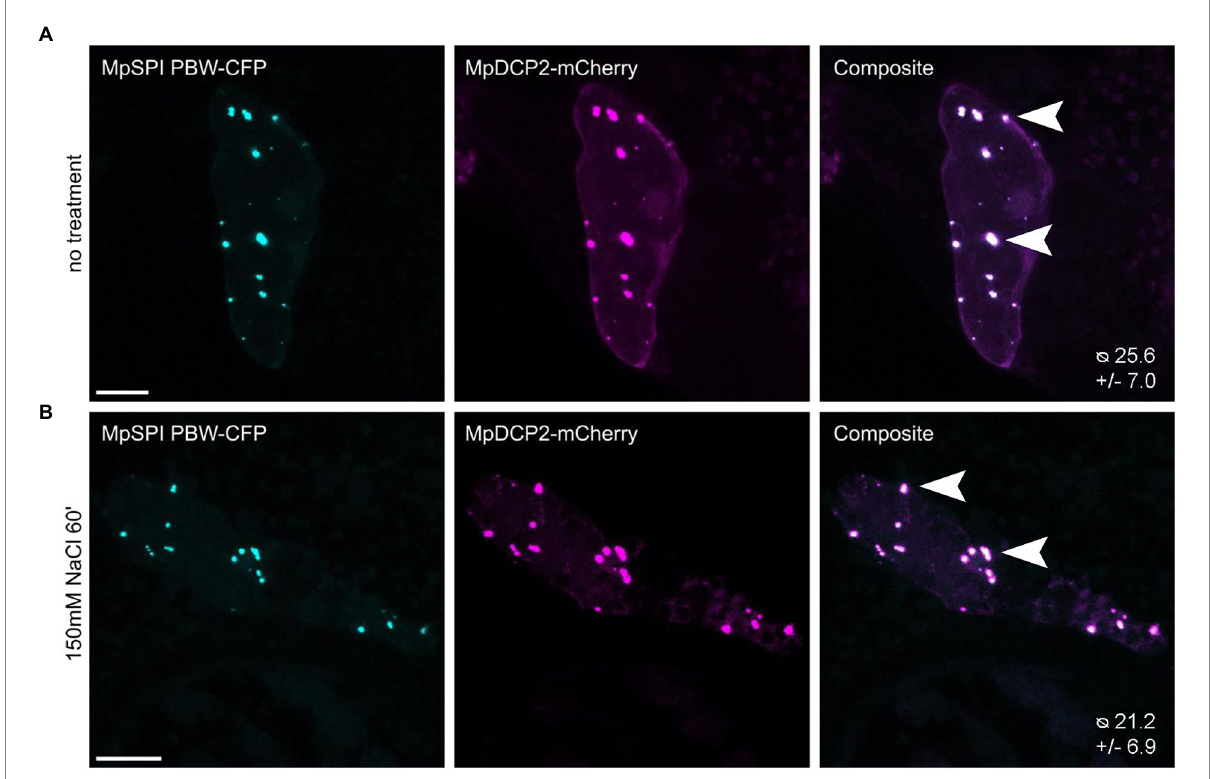
FIGURE 6 MpSPI PBW co-localizes with P-Bodies in M. polymorpha. Transient co-expression of MpSPI PBW with MpDCP2 in Tak-1 epidermal cells (A) under non-stress conditions and (B) salt stress (150 mM NaCl for 60 min). MpSPI PBW granule number in the co-bombardment shown in A and B was determined in n = 14 cells before and after salt treatment. No significant difference in granule number was detected with a two-tailed, unpaired Student’s t -test at p < 0.05. Arrowheads indicate areas of co-localization. Scale bars: 20 μ m.